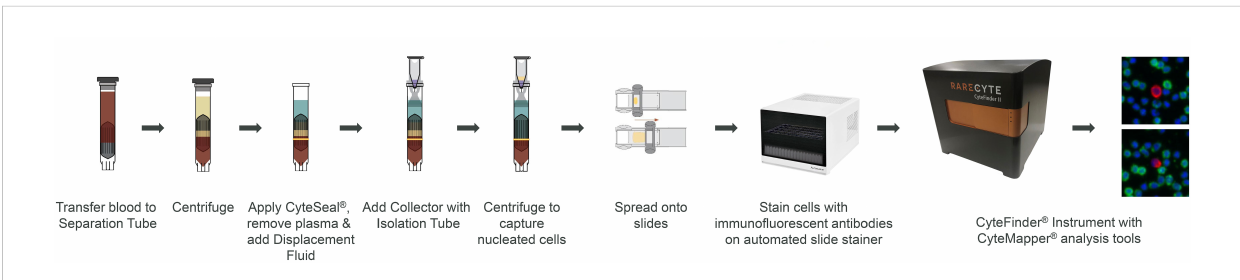
FIGURE 1 CTC enumeration work fl ow using the AccuCyte-CyteFinder system. AccuCyte isolation involves transferring 7.5 mL of blood to a Separation Tube and centrifuging to separate blood into the three main components: red blood cells, nucleated cell layer and plasma. A CyteSeal is applied between the red blood cell and nucleated cell layer and plasma is removed. Another centrifugation results in the capture of nucleated cells into the isolation tube. Nucleated cells are spread onto slides using the CyteSpreader device and then stained using RarePlex kits and an automated slide stainer. Slides are then scanned on the CyteFinder instrument and analyzed using the CyteMapper software to identify rare cells based on their marker